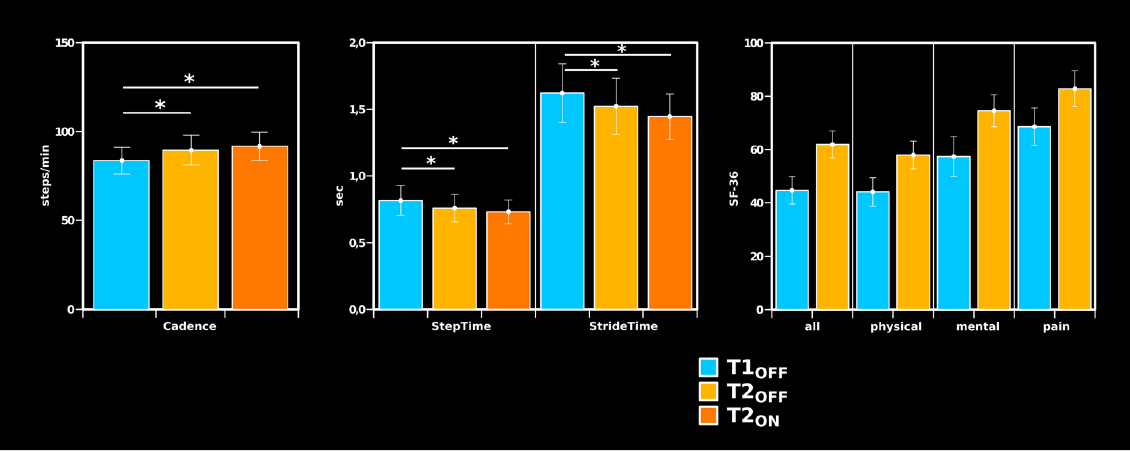
Figure 2. Behavioral results. Gait parameters and SF-36 questionnaire across assessment time point and stimulation condition. Error bars depict the standard error of